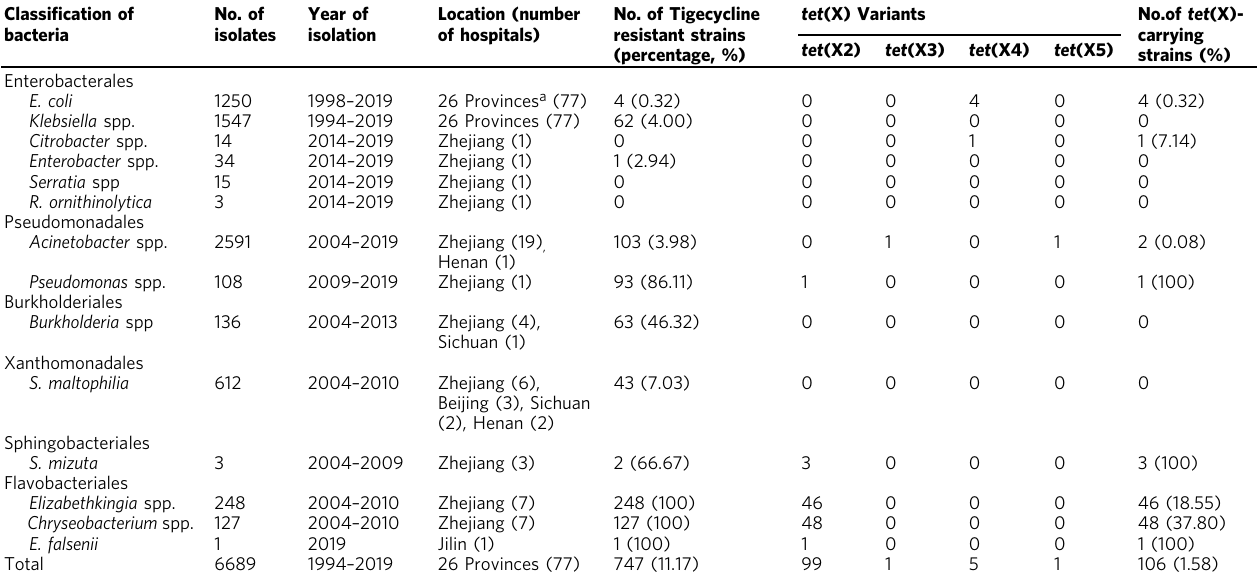
Table 1 Overview of isolation rate and tet (X) carriage rate of clinical isolates described in this study. Classi fi cation of